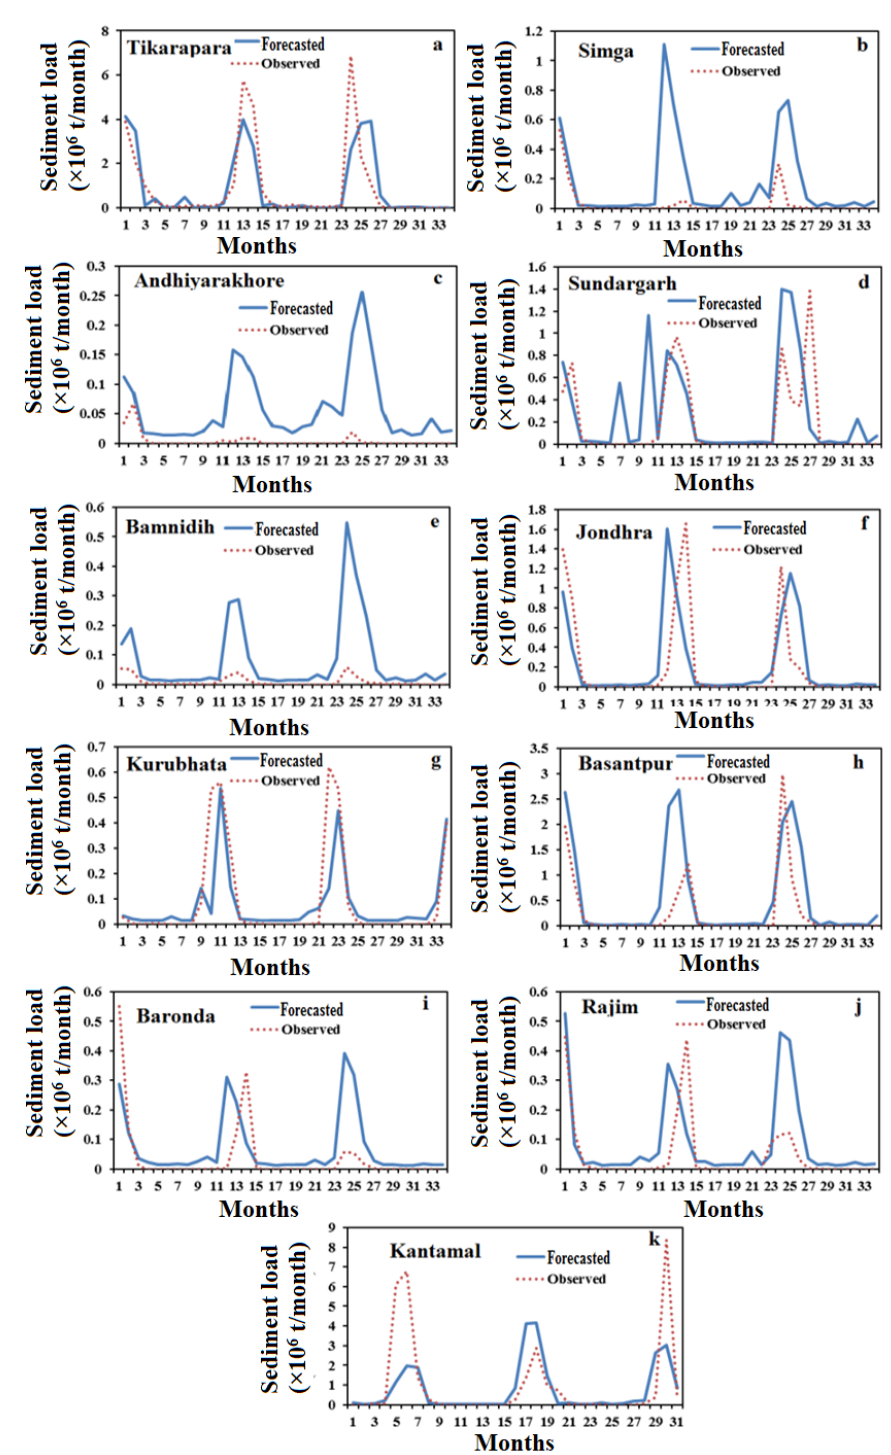
Figure 7. Comparison of the actual and forecasted SL during the testing phase of the ANN-MOGA-51 forecasting model (a-k).